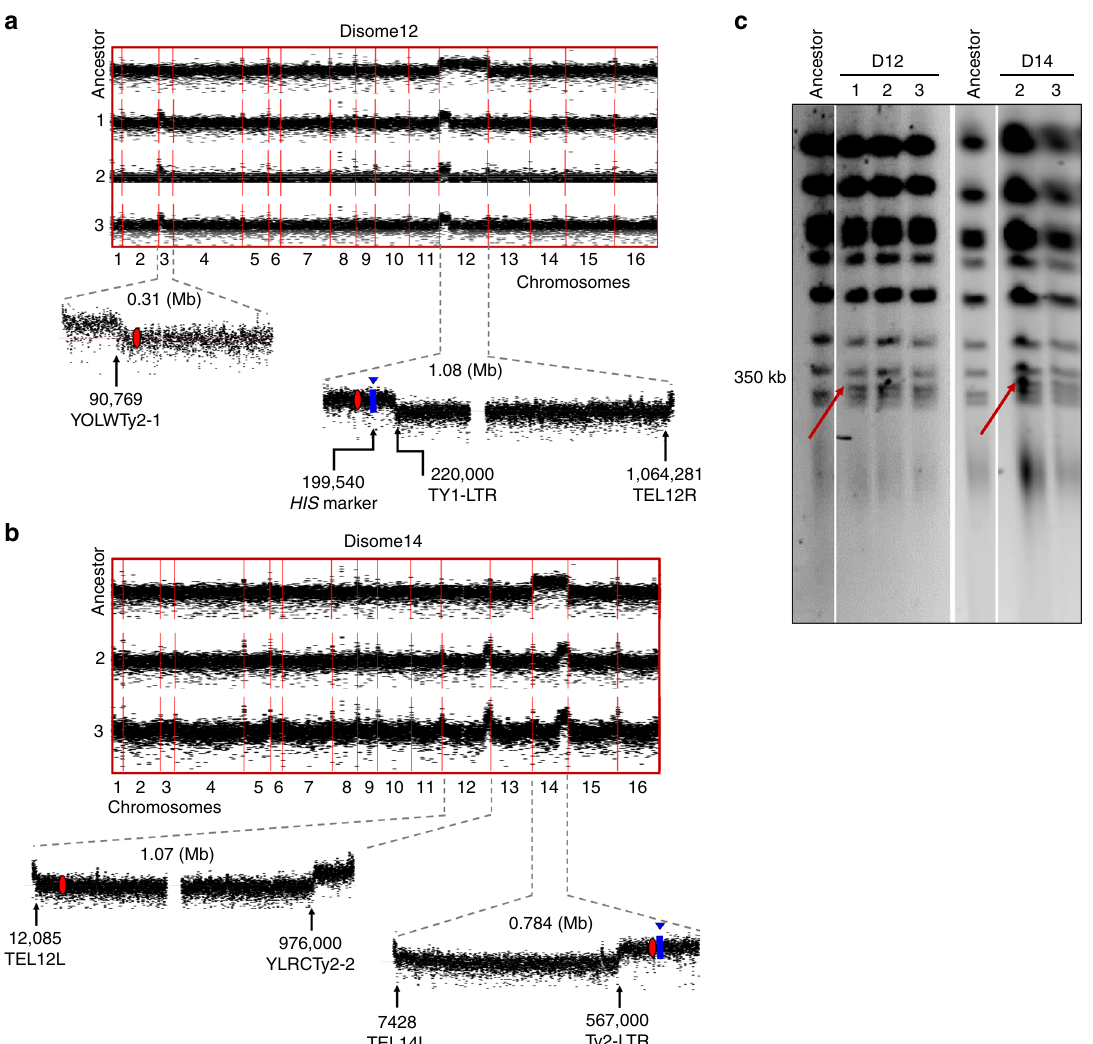
Fig. 3 Karyotype of evolved disome D12 and D14 lines. a Karyotype of ancestor and evolved disome D12 lines and b disome D14 lines. Read depth was calculated in 100-bp windows. The lower sections of these panels zoom in the chromosomal regions with duplication break points. Location of selection markers is shown in blue, and centromeres in red. Gaps in chromosome XII correspond to rDNA regions that were removed for visualization purposes. c Pulse- fi eld gel analysis showing the distribution of chromosome sizes in ancestor and evolved lines of disomes D12 and D14. Red arrows indicate the appearance of new chromosomes in both disomes. Source data for uncut gels is provided as a source data fi